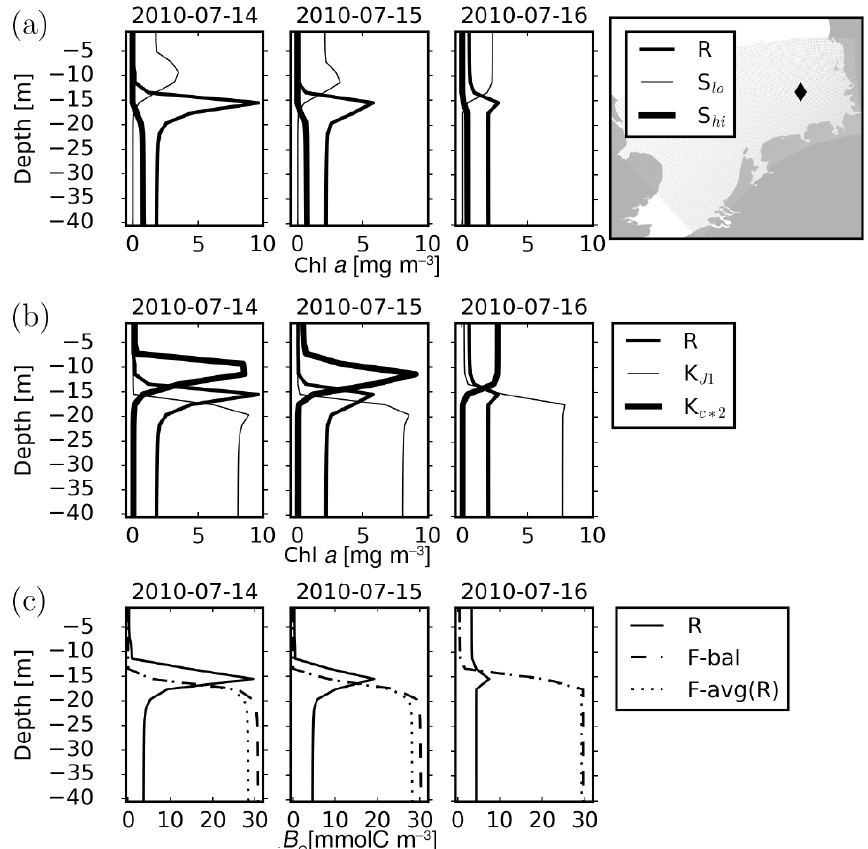
Figure B4. Vertical distribution of the simulated phytoplankton chlorophyll (a–b) and carbon (c) for 3 example days in July 2010 at an example spot (55 ◦ N, 5 ◦ E; shown with the diamond symbol in the inset map) for various model realizations as follow. (a) Phytoplankton = 0.2 and w ∗ = 3.0md − 1 as in Table A3), and S sinking, where R is the reference model (with w 0 lo and S hi are the phytoplankton sinking B B = 0.0md − 1 ) and, respectively, low ( w 0 = 0.2) and high ( w 0 = 3.0) values. (b) The light climate, where R is rate set to constant ( w ∗ B B B the reference model with the light attenuation within the blue–green spectrum (as described by the length-scale coefficient η 2 in Eq. 2) determined by a background SPM-caused turbidity used as model forcing (see Sect. 2.2.3) and shading by the modeled variables (with specific attenuation coefficients listed in Table A3), K JI is the low attenuation achieved by setting a small ( = 23m) background value for η 2 (characterizing clear-water conditions; Paulson and Simpson, 1977) and keeping the specific attenuation coefficients as in R , and K c ∗ 2 is the high attenuation achieved by setting the specific attenuation coefficients at 2 times their original values and keeping the SPM-caused turbidity as in R . (c) Resource utilization traits of phytoplankton, where R is the reference model with dynamic and optimal allocation of resource utilization traits, and with two non-acclimative model versions (explained in Appendix B3 and shown in Fig. 14): F-bal represents balanced allocations to light harvesting, nutrient acquisition and carboxylation; and F-avg( R ) represents allocation coefficients calculated as the spatiotemporal averages from the reference